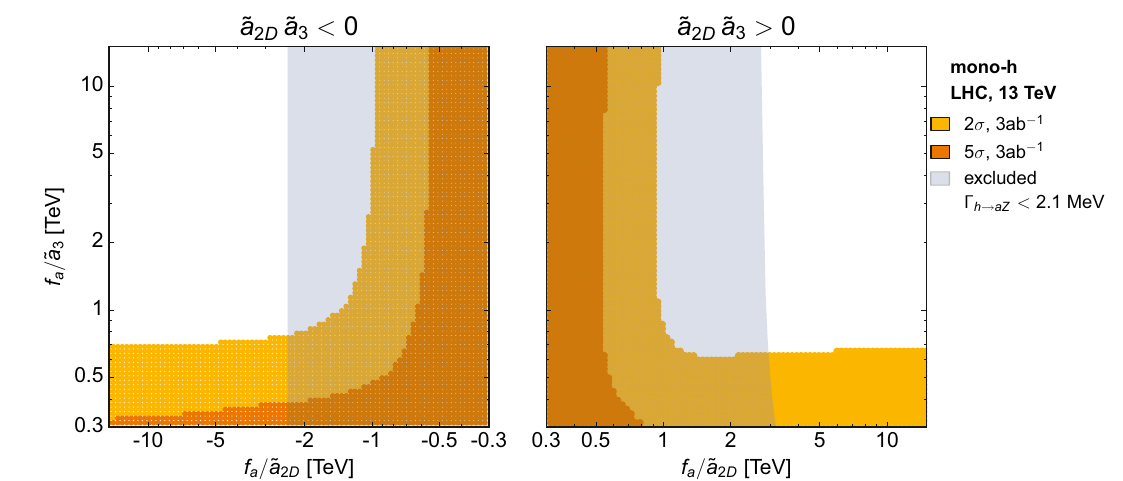
Fig. 13 Contours for 2 σ and 5 σ sensitivity to the mono-H signal at the √ s = 13TeV and for an integrated luminosity of 3000fb − 1 , LHC with for different values of the parameters ( f a / ˜ a 2 D ) and ( f a / ˜ a 3 ) . The left